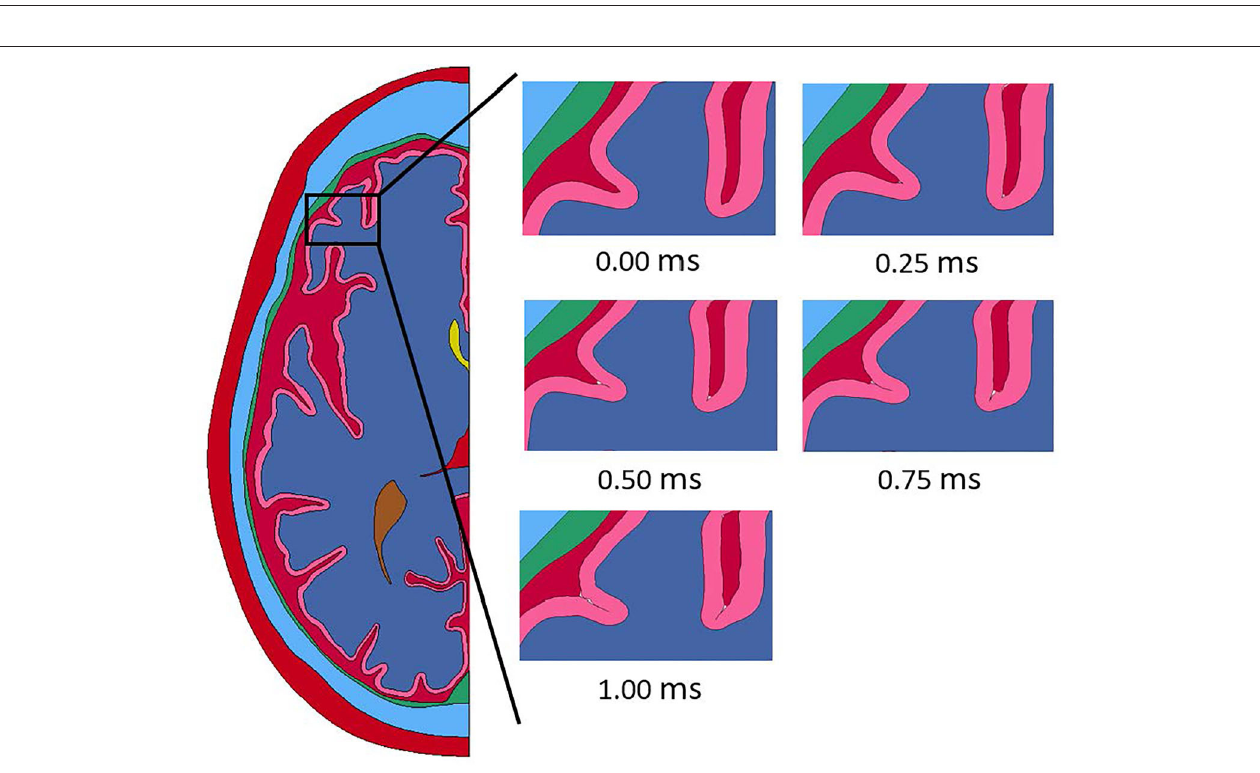
FIGURE 8 | Pressure and distance plot for a sulcus. The distance is measured between points A and B with a negative value representing the points becoming closer together. Pressure is the average of the pressures at points A and B. The initial distance between A-B is ∼ 1.3mm.